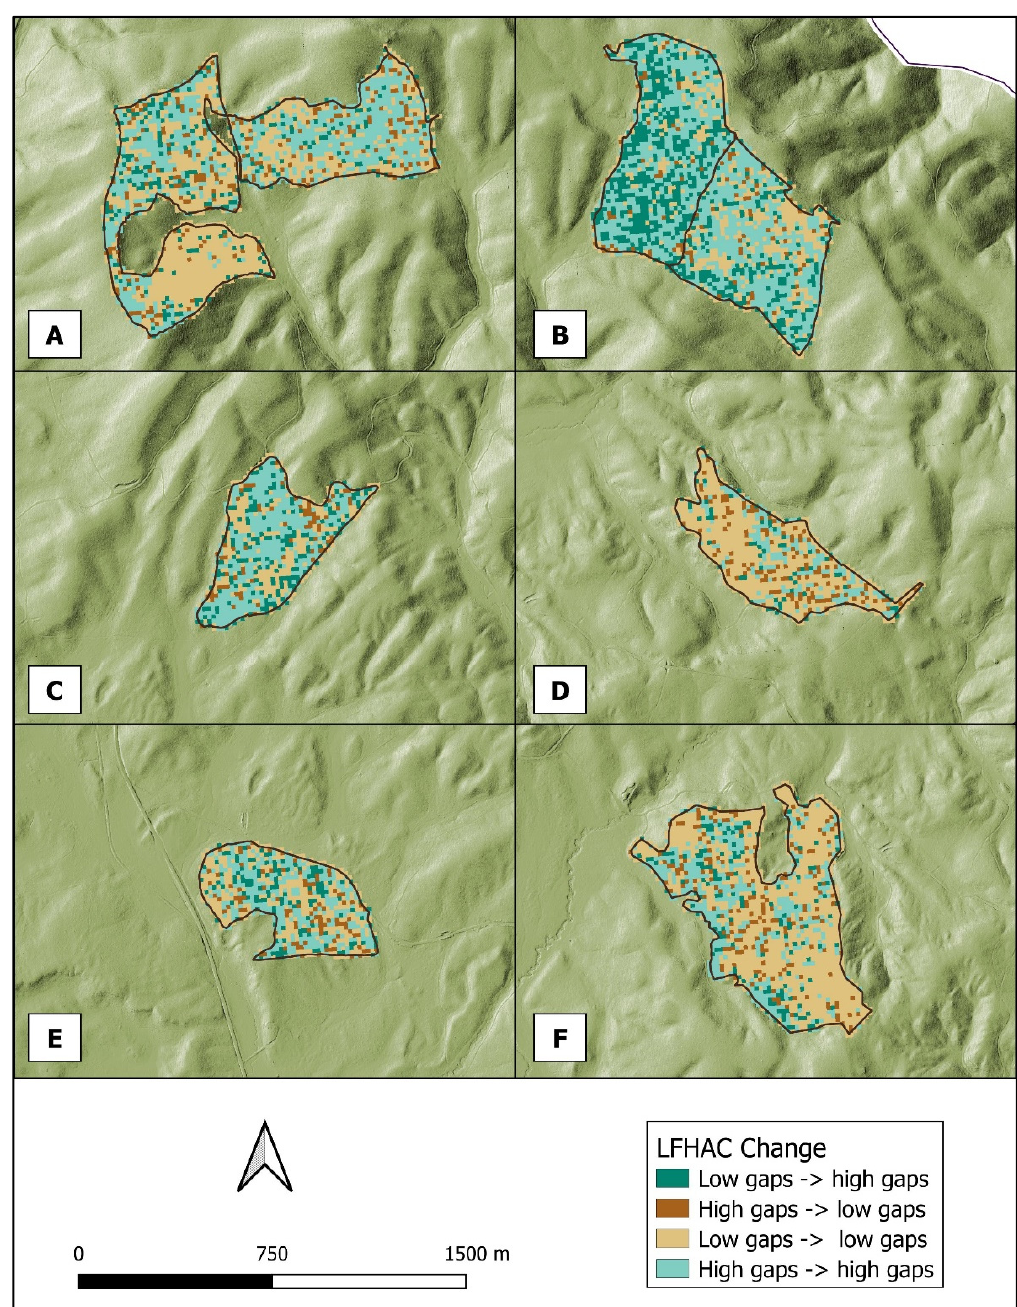
Figure 9. Predicted change in LFHAC following fuel reduction treatment in each sample unit. ( A ) Mixed conifer TH (left) and mixed conifer NT (right). ( B ) Mixed conifer TB (left) and mixed conifer BU (right). ( C ) Ponderosa TH. ( D ) Ponderosa NT. ( E ) Ponderosa TB. ( F ) Ponderosa BU.